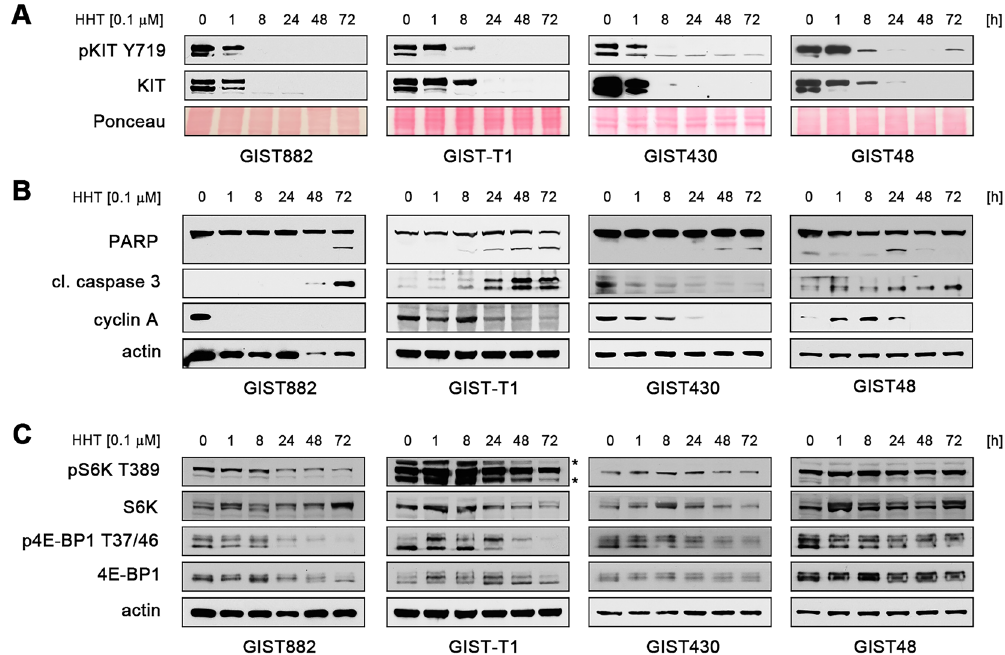
Figure 3. The effect of HHT is time-dependent and leads to secondary inhibition of translation initiation. (A– C) Immunoblot analysis of (A) KIT activation (phosphorylation at Y719) and protein expression, (B) markers of apoptosis and cell cycle regulation and (C) activation of the protein translation regulators ribosomal S6 kinase (S6K; T89) and 4E-BP1 (T37/46) in GIST cells after treatment with DMSO or HHT (0.1 μM) for the indicated times. * indicates unspecific band. Grouped immunoblot images are either cropped from different parts of the same gel or from a separate gel run with another aliquot of the same protein lysate.